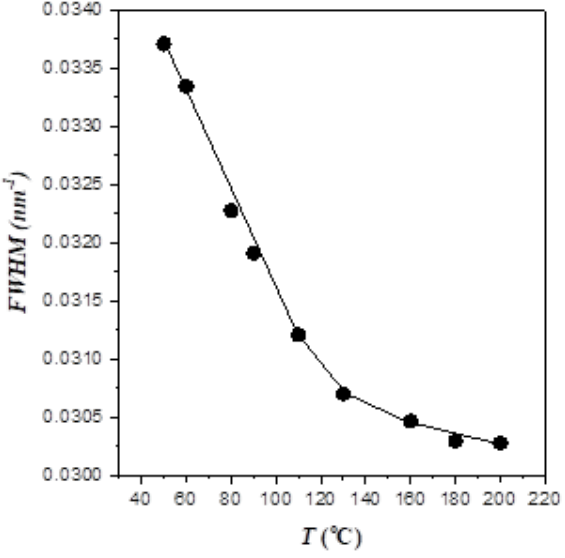
Figure 2. Full width at half-maximum ( FWHM ) of the primary scattering peak as a function of temperature for neat EO4VP. The peak width increased with decreasing temperature, signaling a decrease of segregation strength with decreasing temperature.